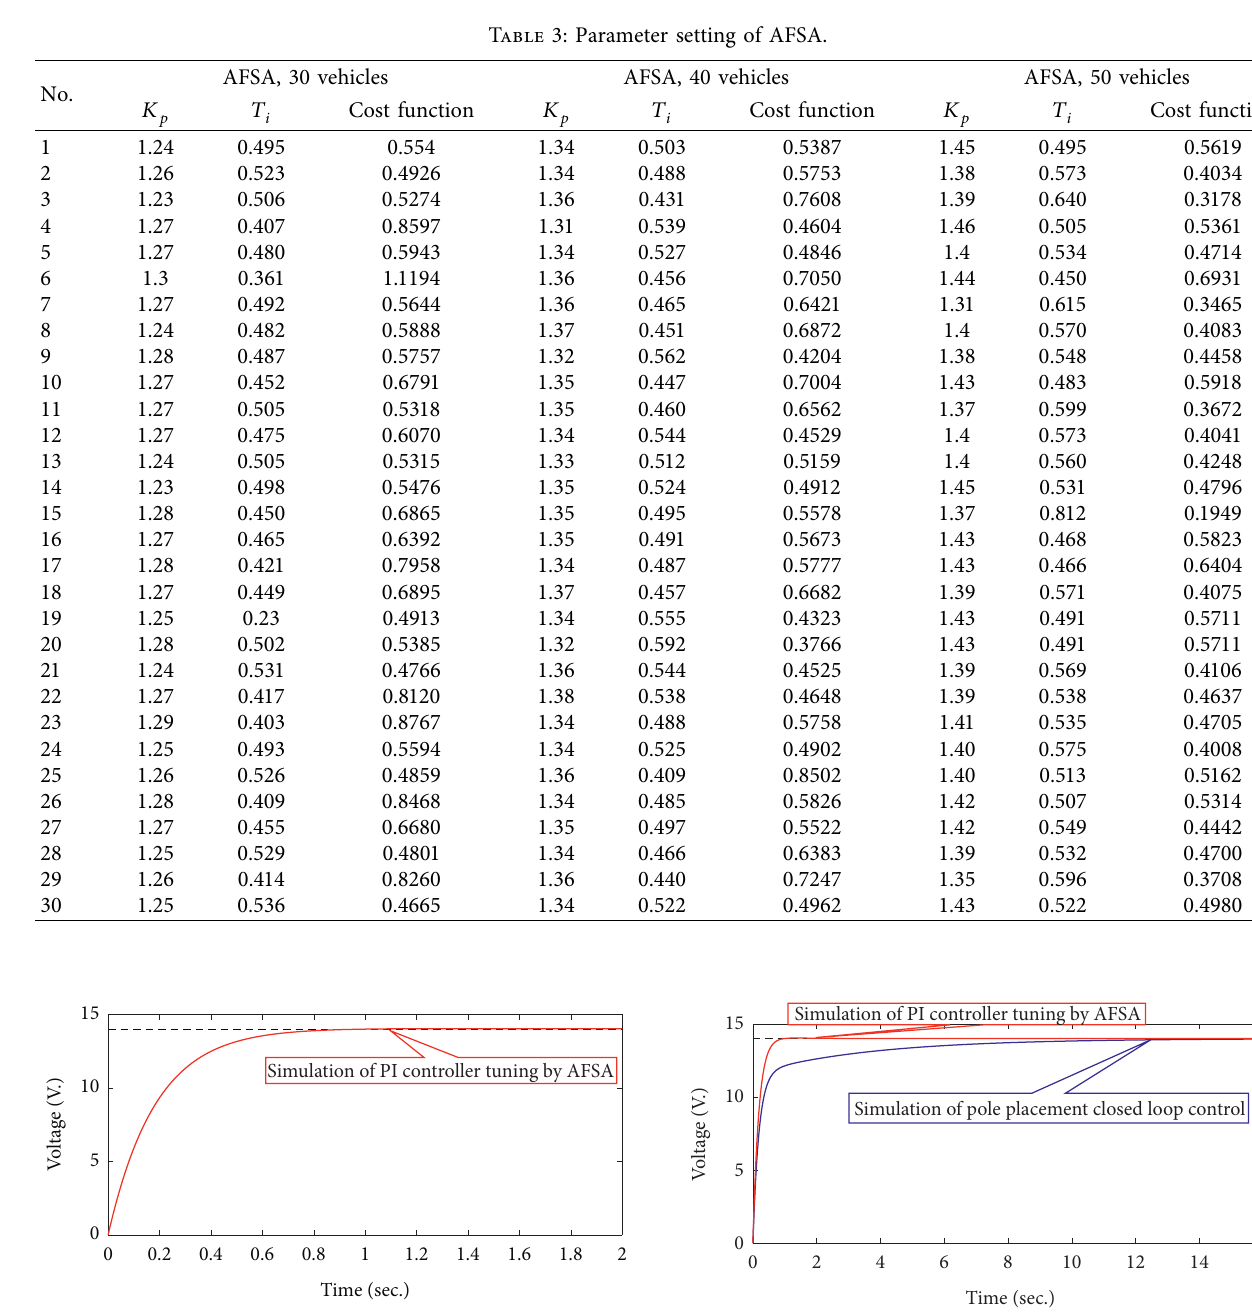
Figure 11: Comparison of the closed-loop control using PI con- troller designed by pole placement method and tuning by